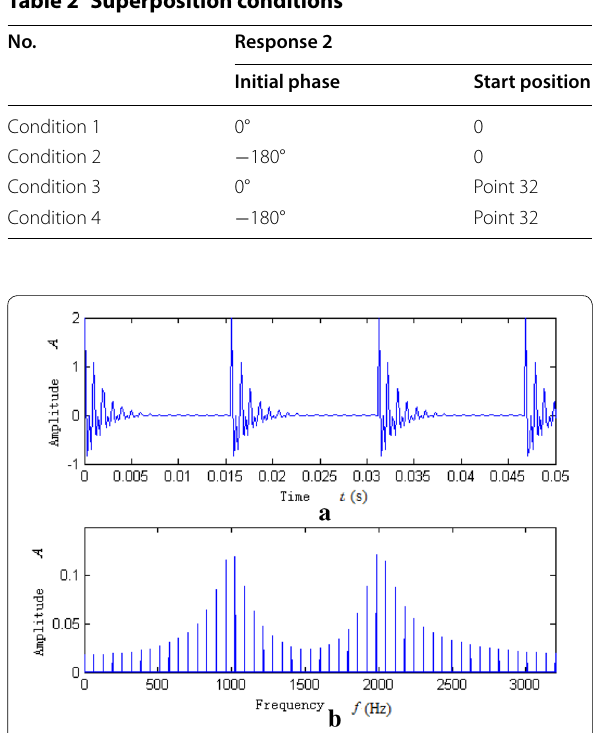
Figure 9 Superposition result under condition 1: ( a ) time waveform, ( b ) FFT spectrum